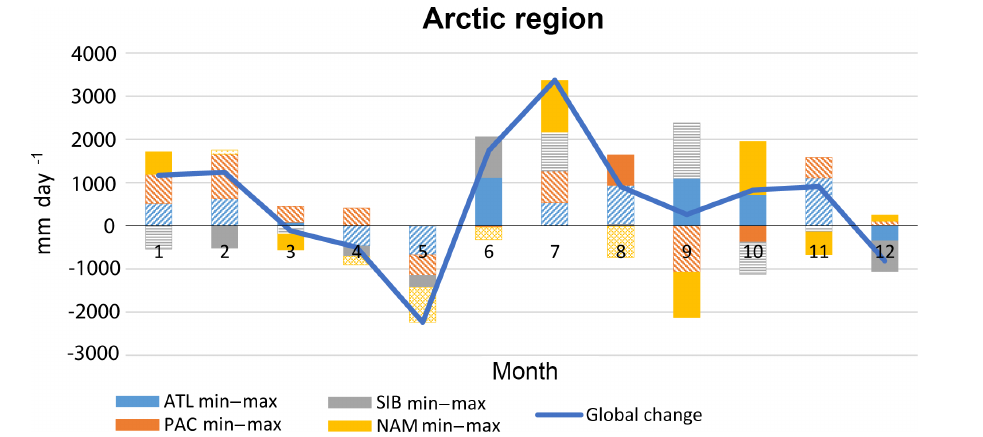
Figure 4. Differences among mean values of moisture transport for precipitation (MTP) (mmday − 1 ) for years with low vs. high Arctic SIE for each source region (coloured bars) and the total value taking into account all the sources for every month (solid line). Filled bars show differences that are statistically significant at the 95% confidence level.